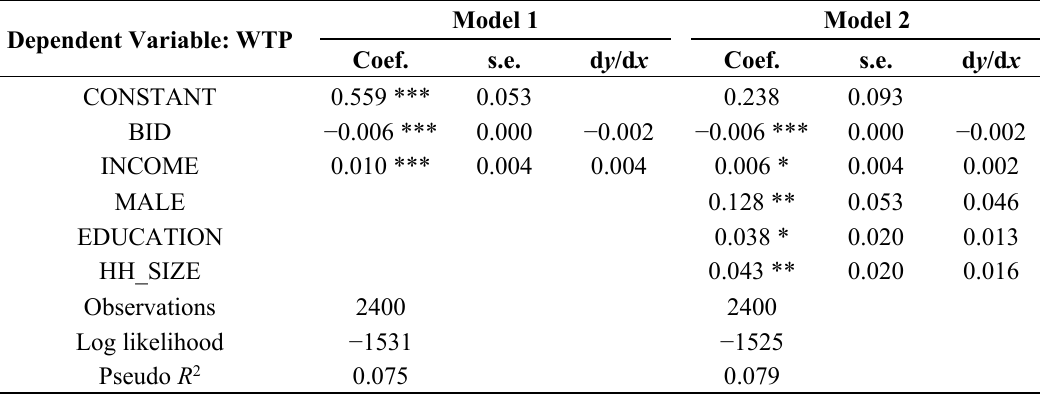
Table 4. Probit regression models displaying determinants of supporting the water management